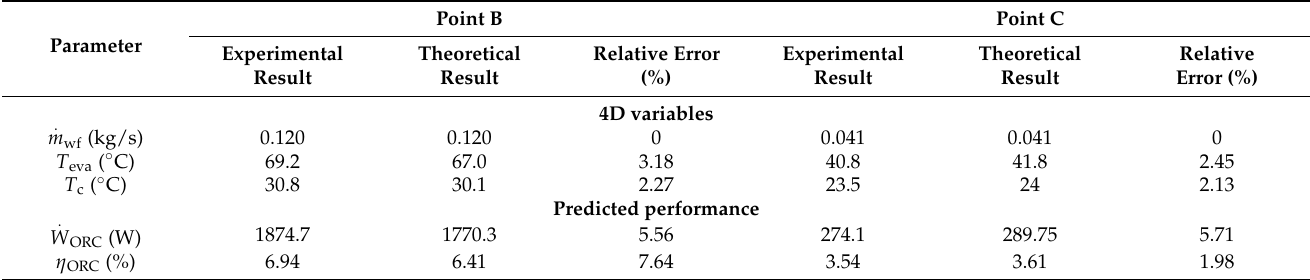
Table 1. Comparison between the experimental and theoretical